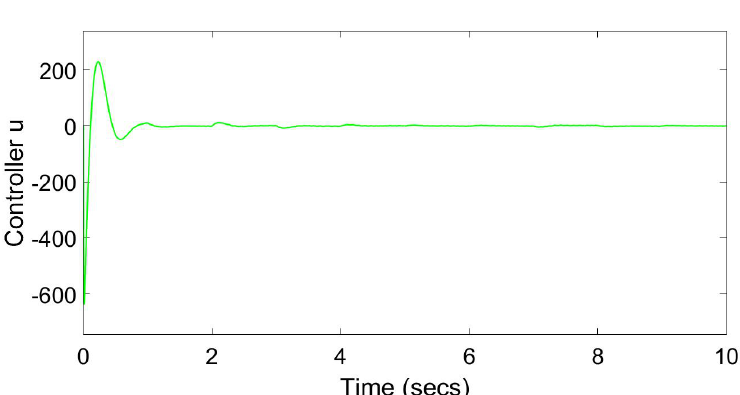
Figure 8. Controller u without probabilistic gain